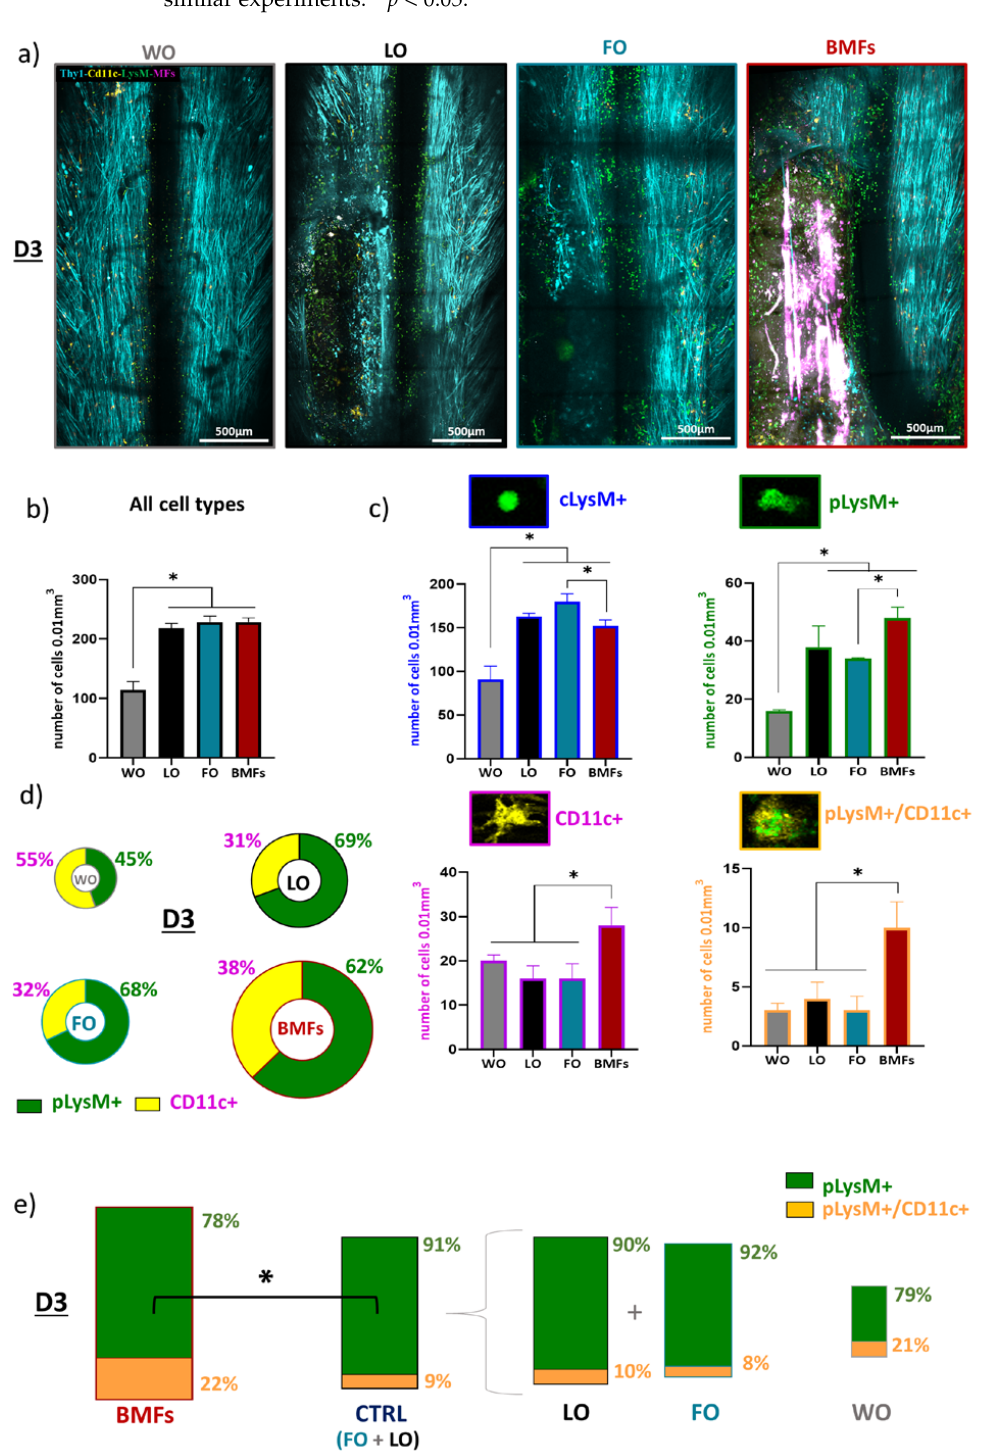
Figure 2. Characterization of immune cell responses in BMFs, FO, LO, WO triple fluorescent mice at three days after surgery. ( a ) Representative maximal intensity projection of 2P z-stack images